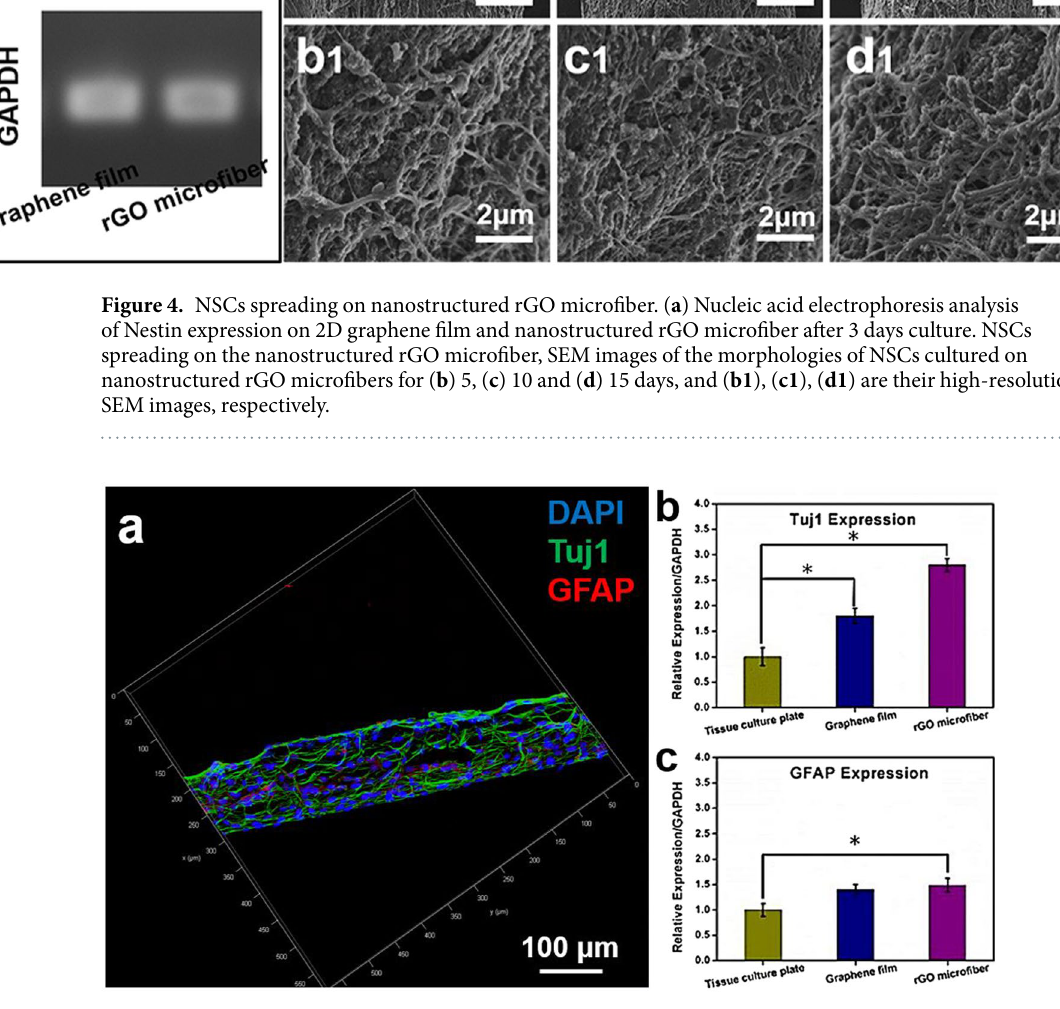
Figure 5. The immunostaining of NSCs on nanostructured rGO microfiber and the qPCR analysis of NSCs on tissue culture plate, 2D graphene film and nanostructured rGO microfiber. ( a ) NSCs were immunostained with neural-specific antibodies after cultured under differentiation condition for 15 days. CLSM fluorescent micrographs of the cells immunostained with DAPI for nuclei (blue) and Tuj1 for neuron (green), GFAP for glia (red). (Scale bar = 100 μ m) ( b ) ( c ) refer to the qPCR analysis of the cells genes expression levels of Tuj1 and GFAP on tissue culture plate, 2D graphene film and nanostructured rGO microfiber for 15 days under neural differentiation conditions. ( * р ≤ 0.05, n =